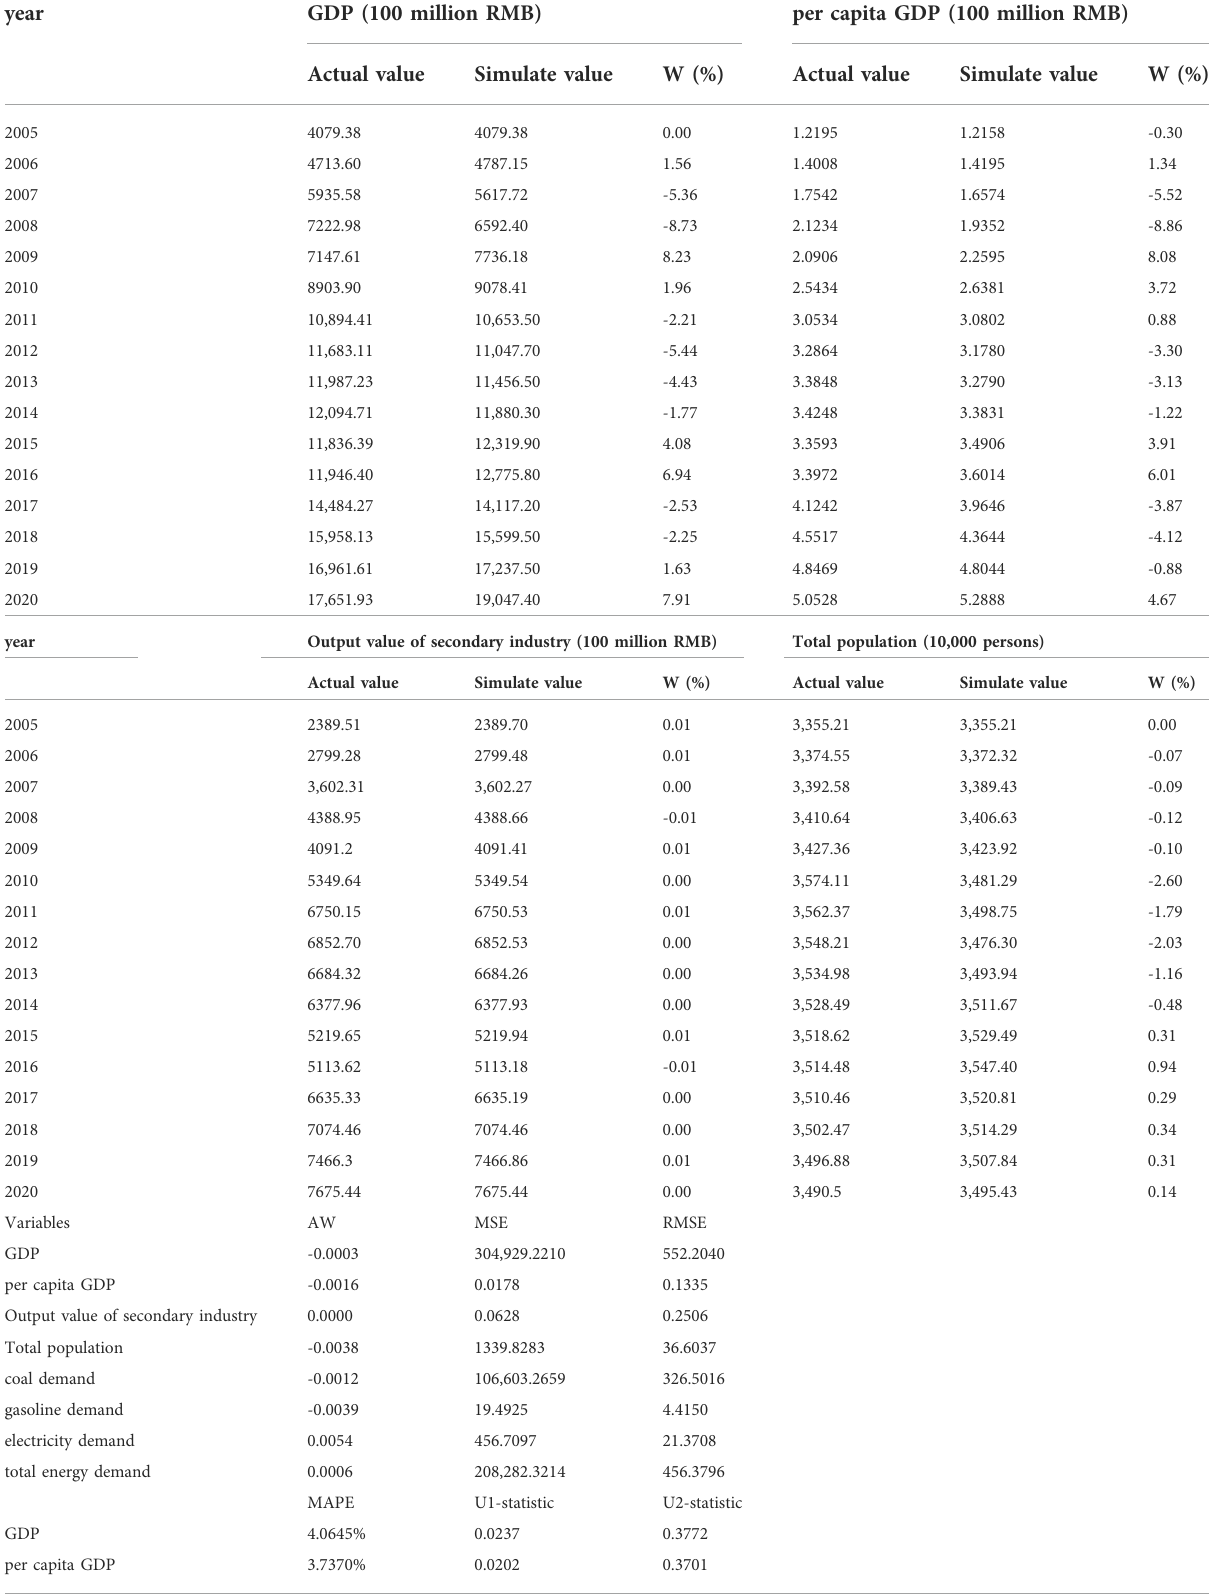
TABLE 3 Historical test results for some